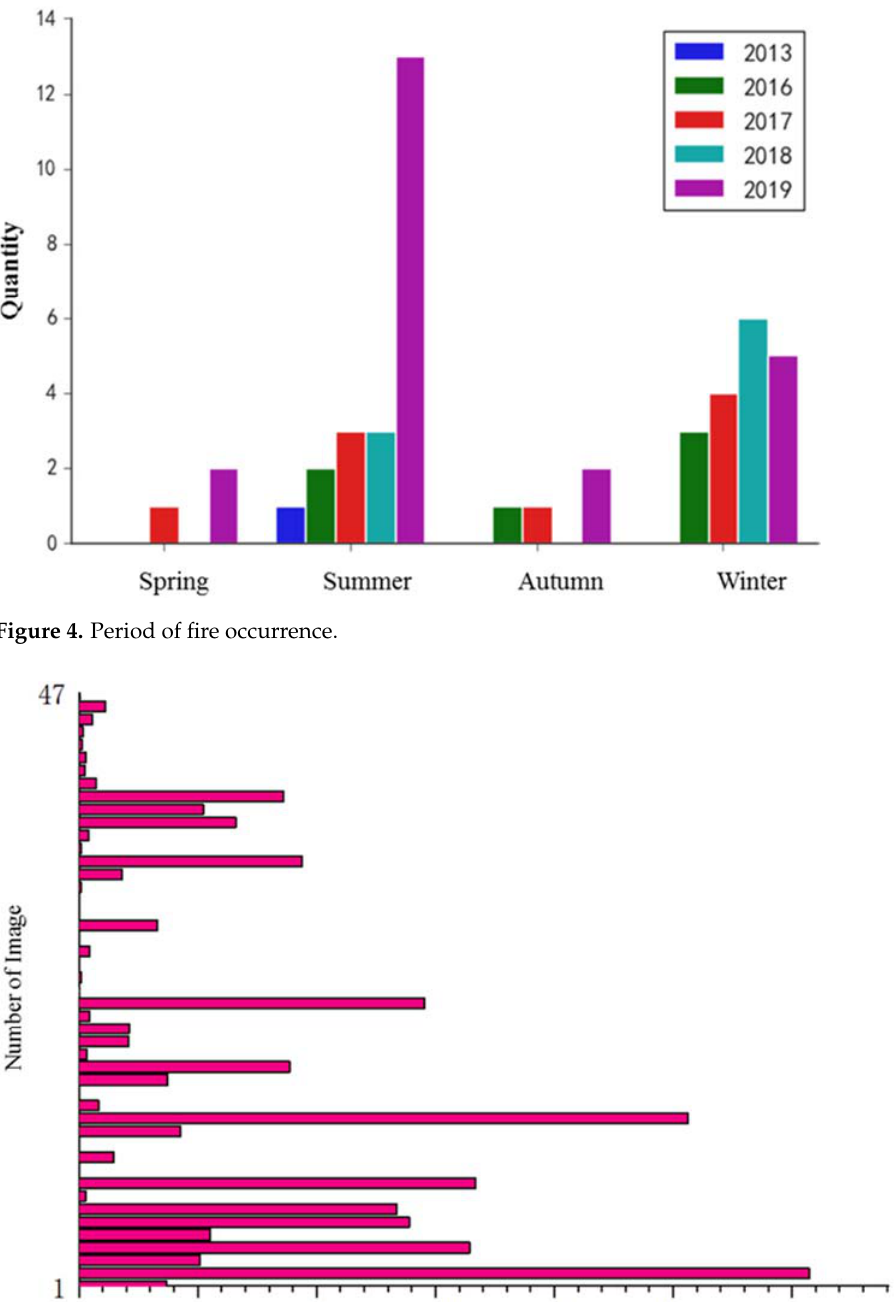
Figure 5. The proportion of smoke pixels of different images.